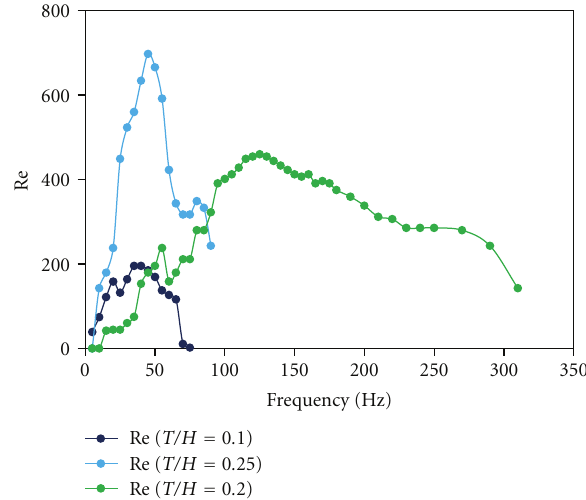
Figure 9: The Reynolds number of water flow under di ff erent T/H ratios.